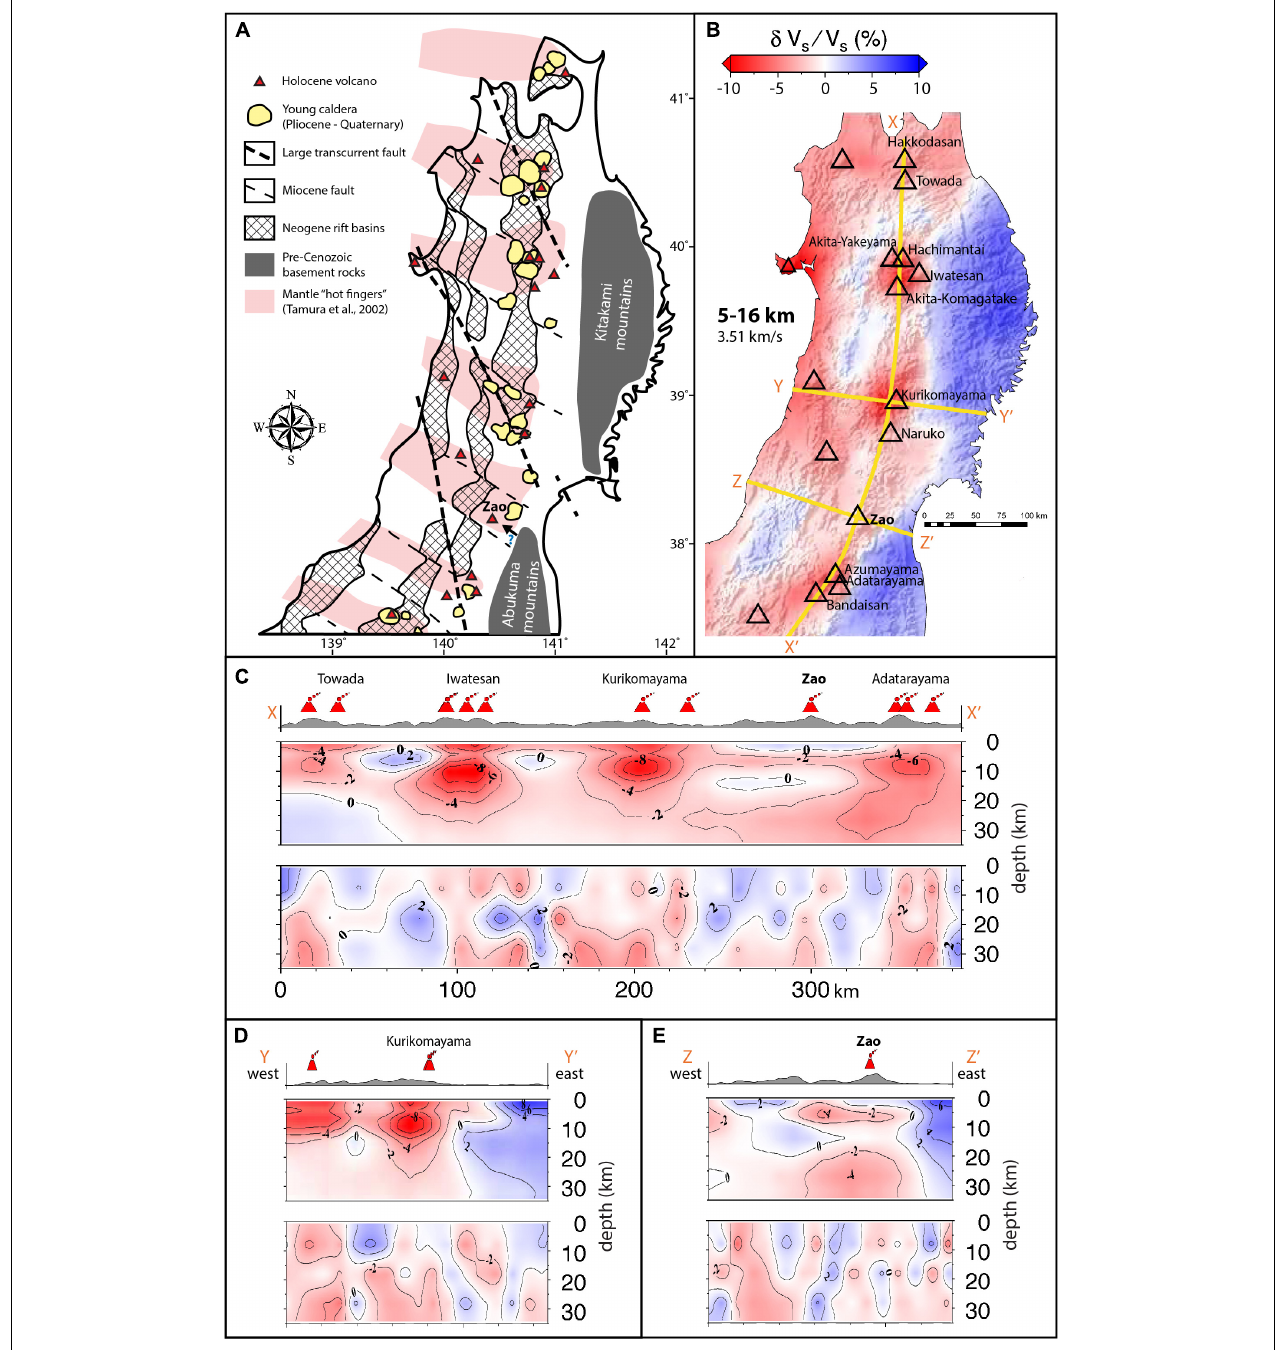
FIGURE 1 | (A) Simplified geological map of the Tohoku region, showing major faults partially offsetting Neogene rift basins (adapted from Yoshida et al., 2014). Mantle low-velocity zones (“hot fingers” of Tamura et al., 2002) are shown, as well as the location of young (Pliocene to Quaternary) calderas (Yoshida et al., 1999; Acocella et al., 2008) and Holocene arc volcanoes (Global Volcanism Program, 2013). At depth, pre-Cenozoic basement rocks of the Abukuma mountains may have displaced (indicated by a small arrow with a blue question mark) into the area of Zao volcano through transcurrent faulting. (B) Average δ V S /V S of the recent ambient noise tomography model (Chen et al., 2018) in the Tohoku region, in the depth range of 5–16 km. Note the good correspondence of the greatest arc-front anomalies with the location of young caldera clusters in panel A . Yellow lines indicate cross-sections in panels C–E . (C) Along-arc cross-section of the shear-wave velocity anomaly to a depth of 34 km. Top section shows ambient noise tomography (Chen et al., 2018), as in panel B , with highest sensitivity in the mid- to upper crust. Bottom section shows conventional body-wave tomography model (Niu et al., 2018), using local earthquakes, with higher sensitivity in the lower crust. (D,E) Across arc profiles through Kurikomayama and Zao volcanoes. Data sources and scales as in panel C .